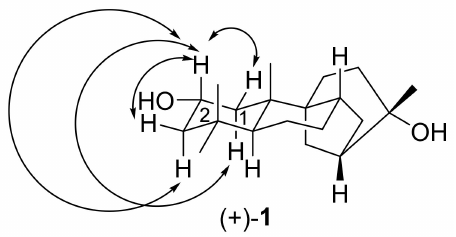
Figure 4. Vicinal coupling of H–C(2) in (+)-stemodin ( 1 )